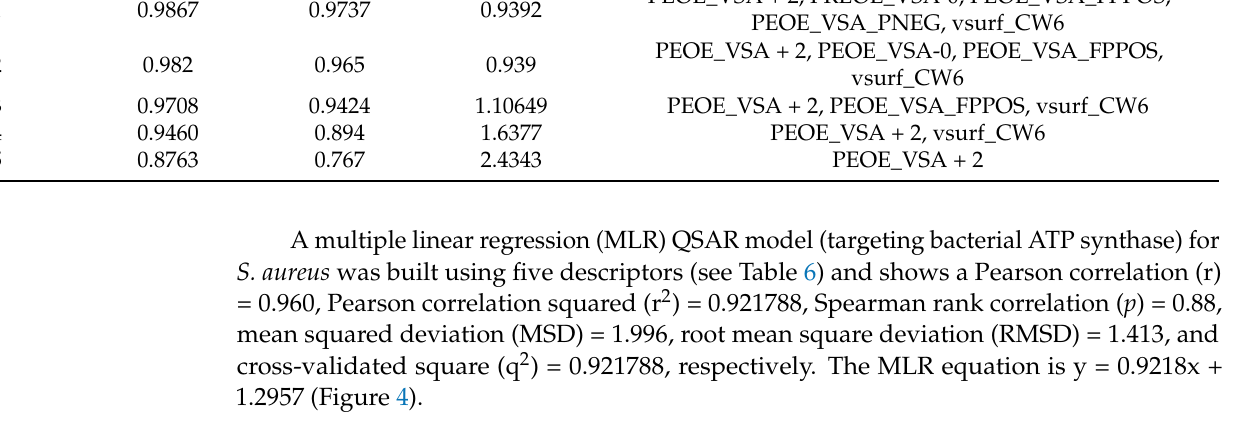
1.2957 (Figure 4).